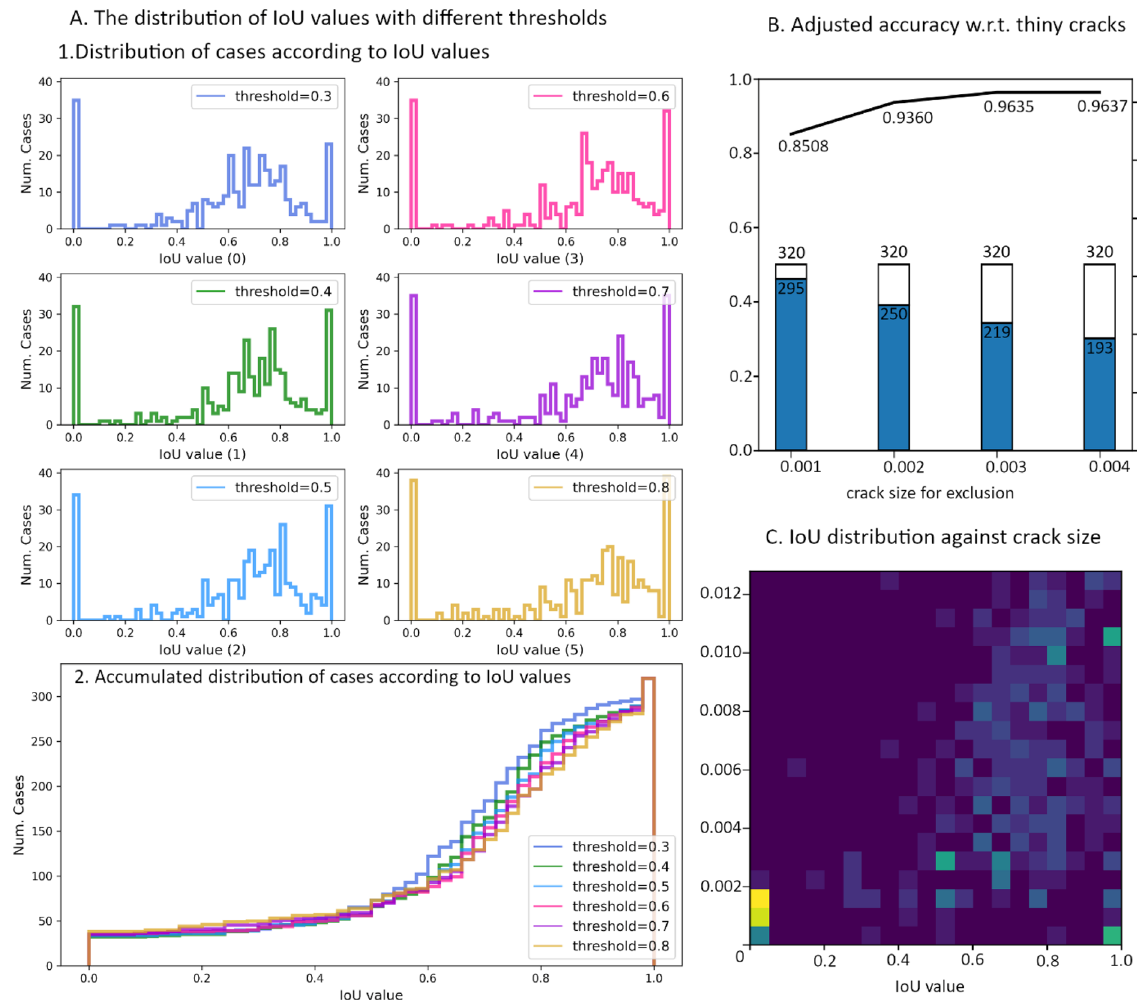
Figure 10. The relationship between crack size and evaluation metrics. The IoU values of 320 test cases are calculated by the model trained with γ = 0.1 and α = 0.9 . ( A ) 1. the 6 histograms of the IoU values that are calculated with 6 different binarization threshold ( T bin = 0.3, 0.4, 0.5, 0.6, 0.7, 0.8); 2. the accumulated histograms of the IoU values that are calculated with 6 different thresholds. ( B ) The adjusted accuracy for test data after excluding tiny crack cases. The line plot presents the accuracy that is re-calculated when excluding cases with crack size less than 0.001, 0.002, 0.003, and 0.004; the bar chat shows the number of samples after excluding the samples with tiny cracks against the total number of samples in test dataset. ( C ) IoU values distribution w.r.t crack